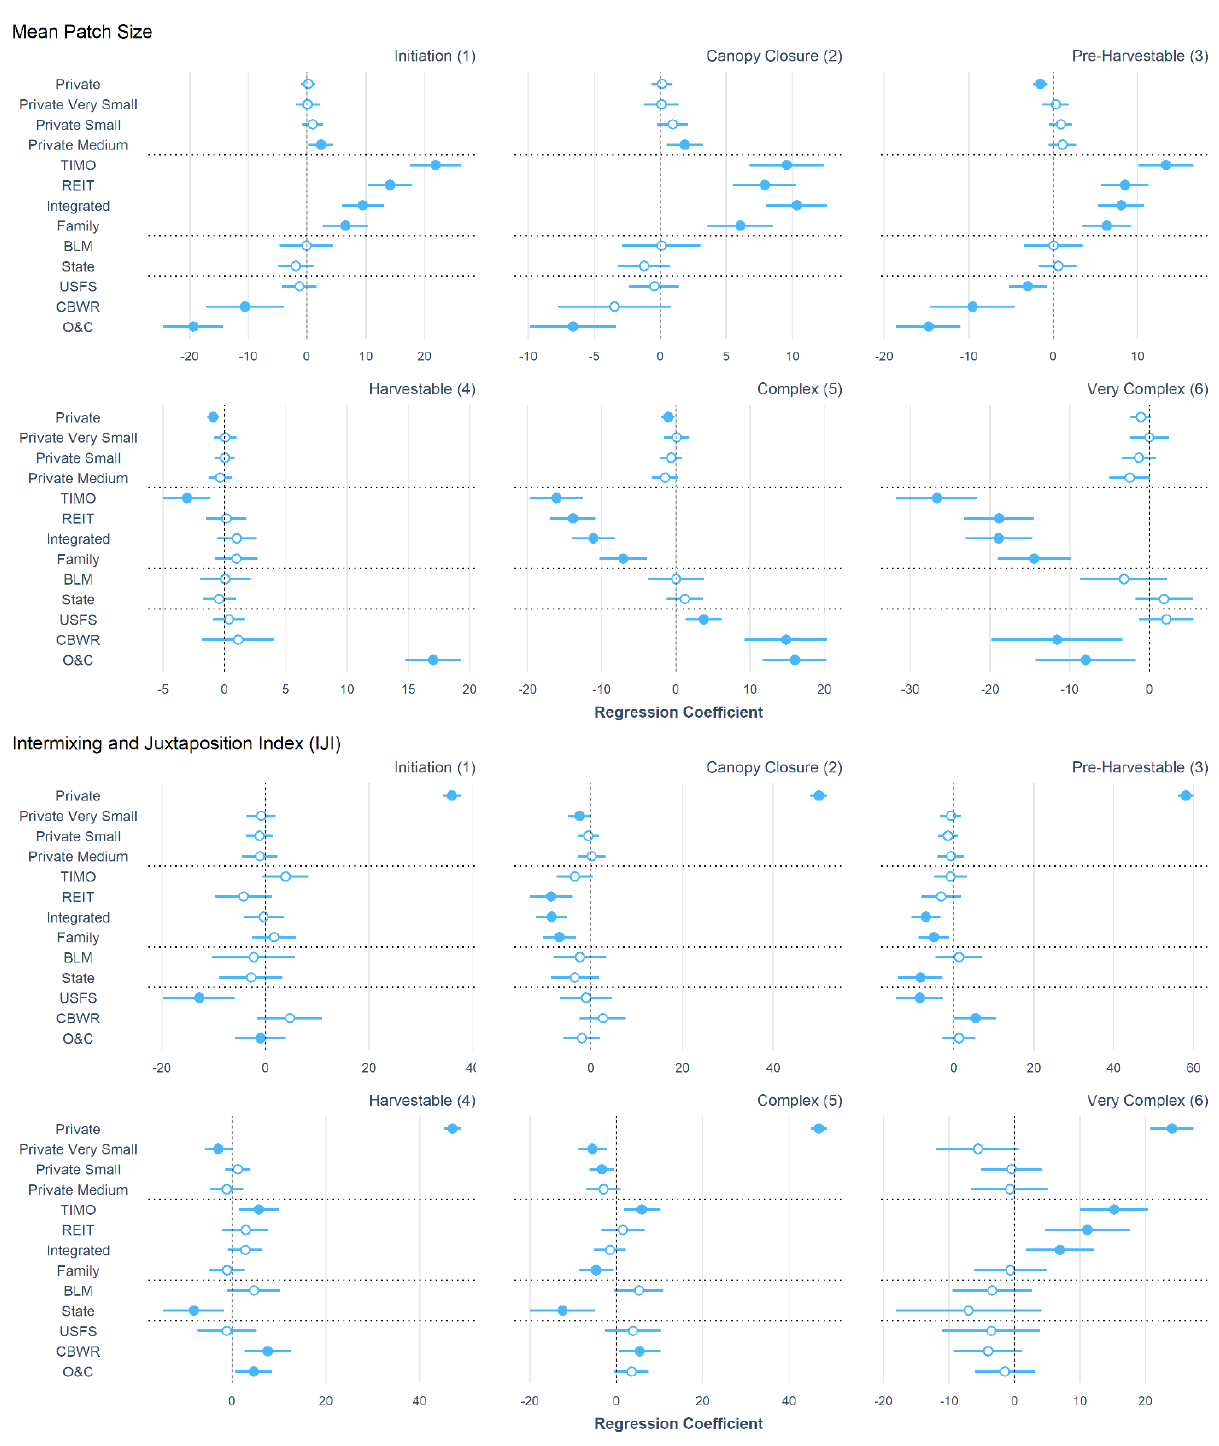
Figure 5. Values and influence (coefficient term) of the ownership type variable to model mean patch size and IJI for each structure class, given each property size and the proportion of that structure class within each property. Each subplot (1–6) corresponds to the six forest structure classes. Filled circles indicate mean significance for the ownership terms at p < 0.05; open circles indicate mean significance for the ownership terms at p > 0.05. Lines show the 95% confidence interval of values for the coefficient term. More negative coefficient terms indicate that mean patch size or IJI was smaller, given property size and structure class proportion, while more positive coefficient terms indicate that mean patch size or IJI was larger, given property size and structure class proportion.